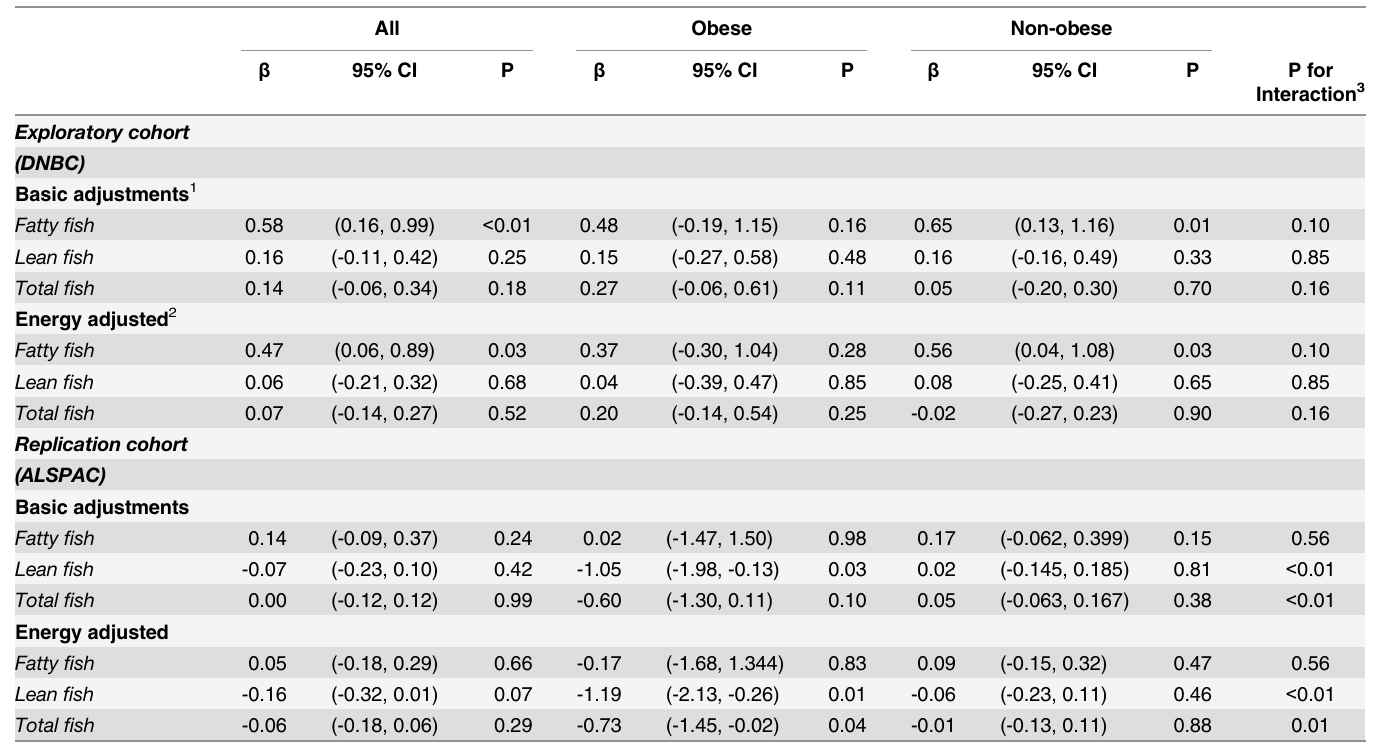
Table 2. Association between intake of fish (weekly servings) and subsequent gestational weight gain (kg). All